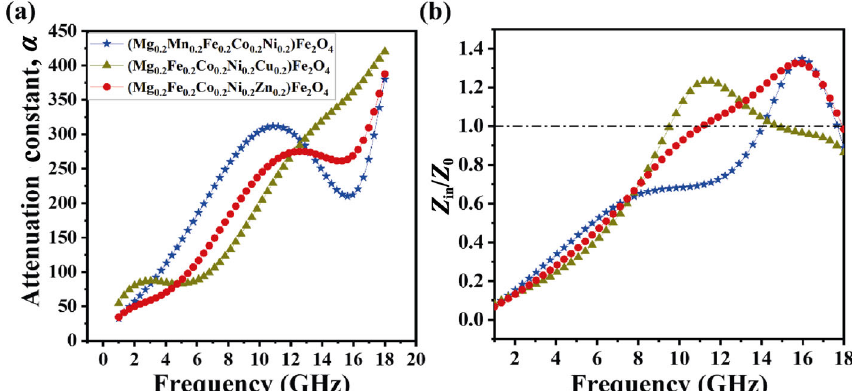
Fig. 9 (a) Comparison of attenuation constant ( α ) and (b) impedance match ( Z in / Z 0 ) of HE MFe 2 O 4 samples at 2.2